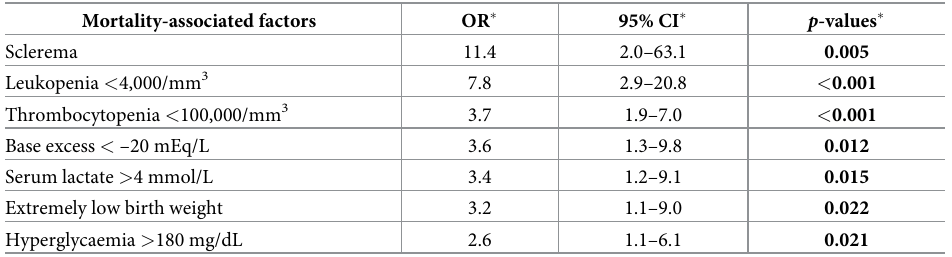
Table 3. Multivariable analysis for factors significantly associated with mortality.